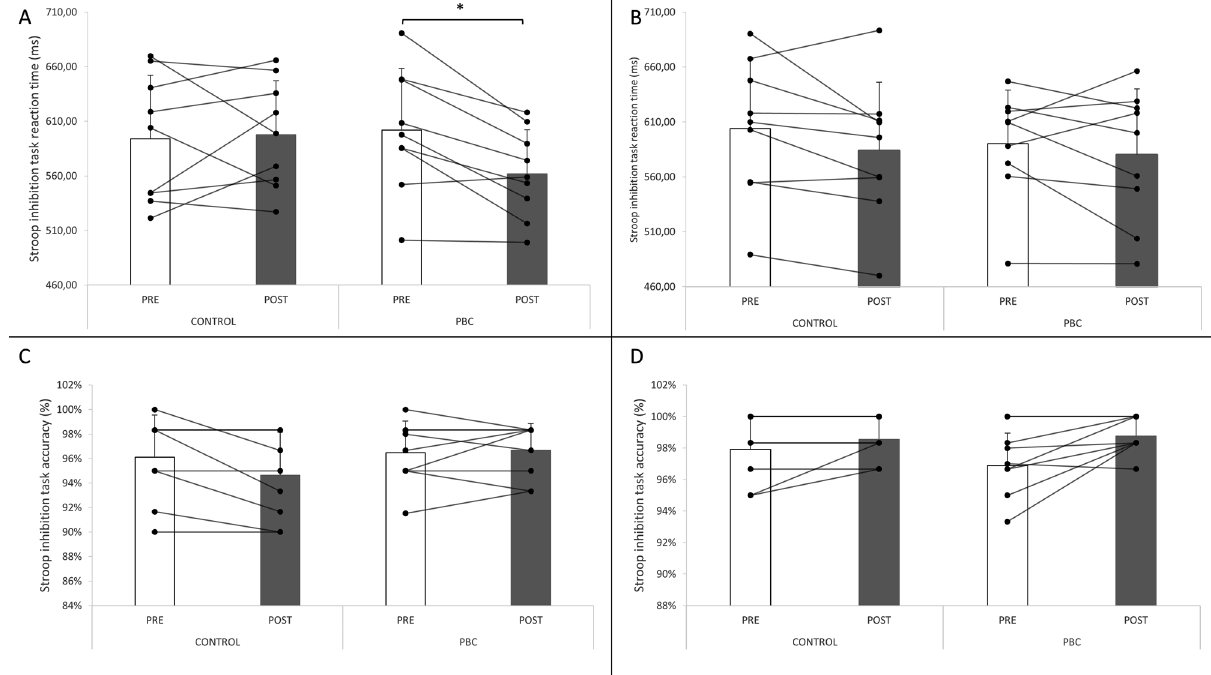
Figure 3. Reaction time and accuracy to the Stroop task in males ( A and C ) and females ( B and D ) before and after PBC (partial body cryotherapy) and control conditions. *Significant ( P < 0.05).